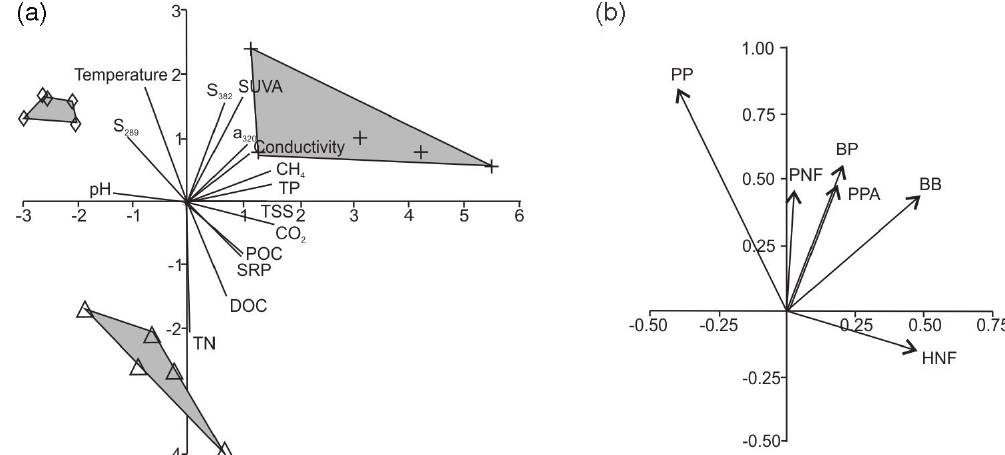
Figure 4. (a) Seasonality in pond environmental variables illustrated with principal component analysis during late winter (triangles), sum- mer surface (diamonds) and summer bottom (crosses). (b) Spearman correlation coefficients between biological variables and principal components 1 ( x axis) and 2 ( y axis). BP – bacterial production, BB – bacterial biomass, HNF – heterotrophic nanoflagellate biomass, PP